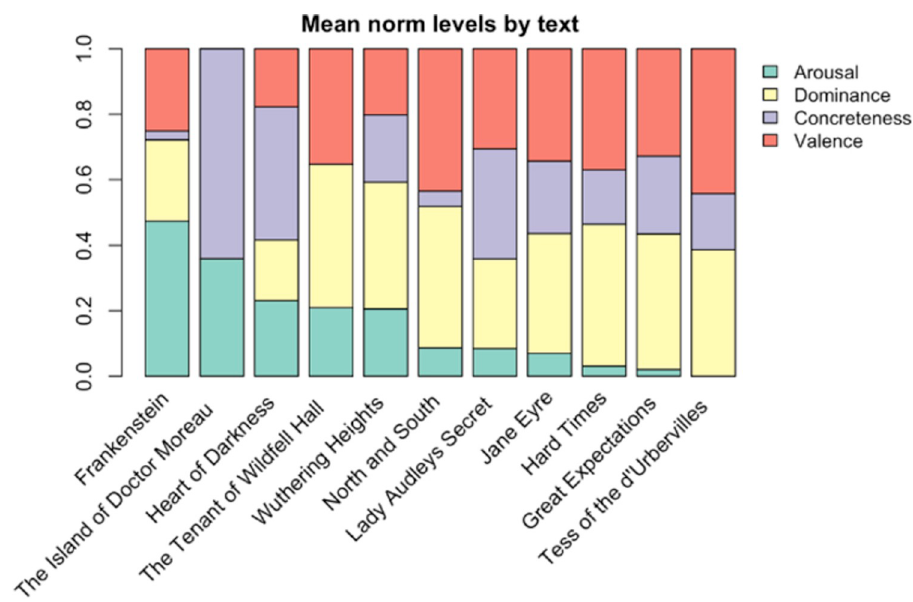
Fig 1. Variables are scaled between 0 and 1 such that a text with a 0 score represents the lowest proportion of that